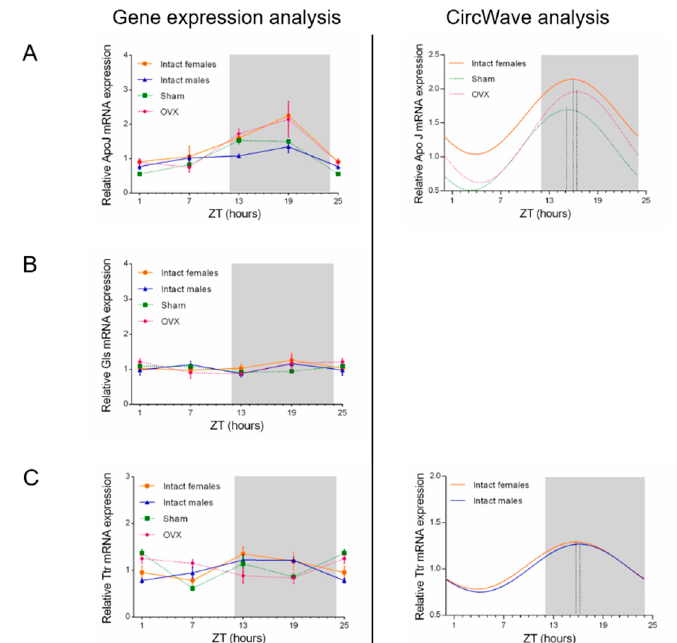
Figure 3. Circadian profile of choroid plexus (CP) A β scavengers. ApoJ, Gls, and Ttr expression was analyzed every 6 h during a 24-h period in intact females (orange), intact males (blue), sham-operated (sham; green), and ovariectomized animals (OVX, pink). Graphs represent the relative mRNA expression levels of ApoJ ( A ), Gls ( B ), and Ttr ( C ) in the CP. Each data point represents the mean ± SEM (n = 4–5). CircWave analysis (right side of the panel) shows the corresponding statistical analysis for rhythmicity (statistical analysis is shown in Table 1). No curve could be fitted for Gls circadian expression. The center of gravity (phase) is represented by the vertical line intersecting each curve. White and grey backgrounds represent light and dark phases, respectively. Data from ZT1 and ZT25 are double-plotted. Table 1. Significance ( p -value) and center of gravity values for each A β scavenger’s gene as determined by CircWave analysis.